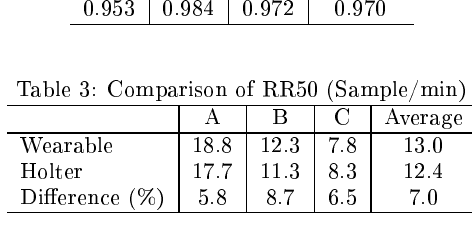
Table 2: Comparison of correlation coe(cid:30)cient of RRI